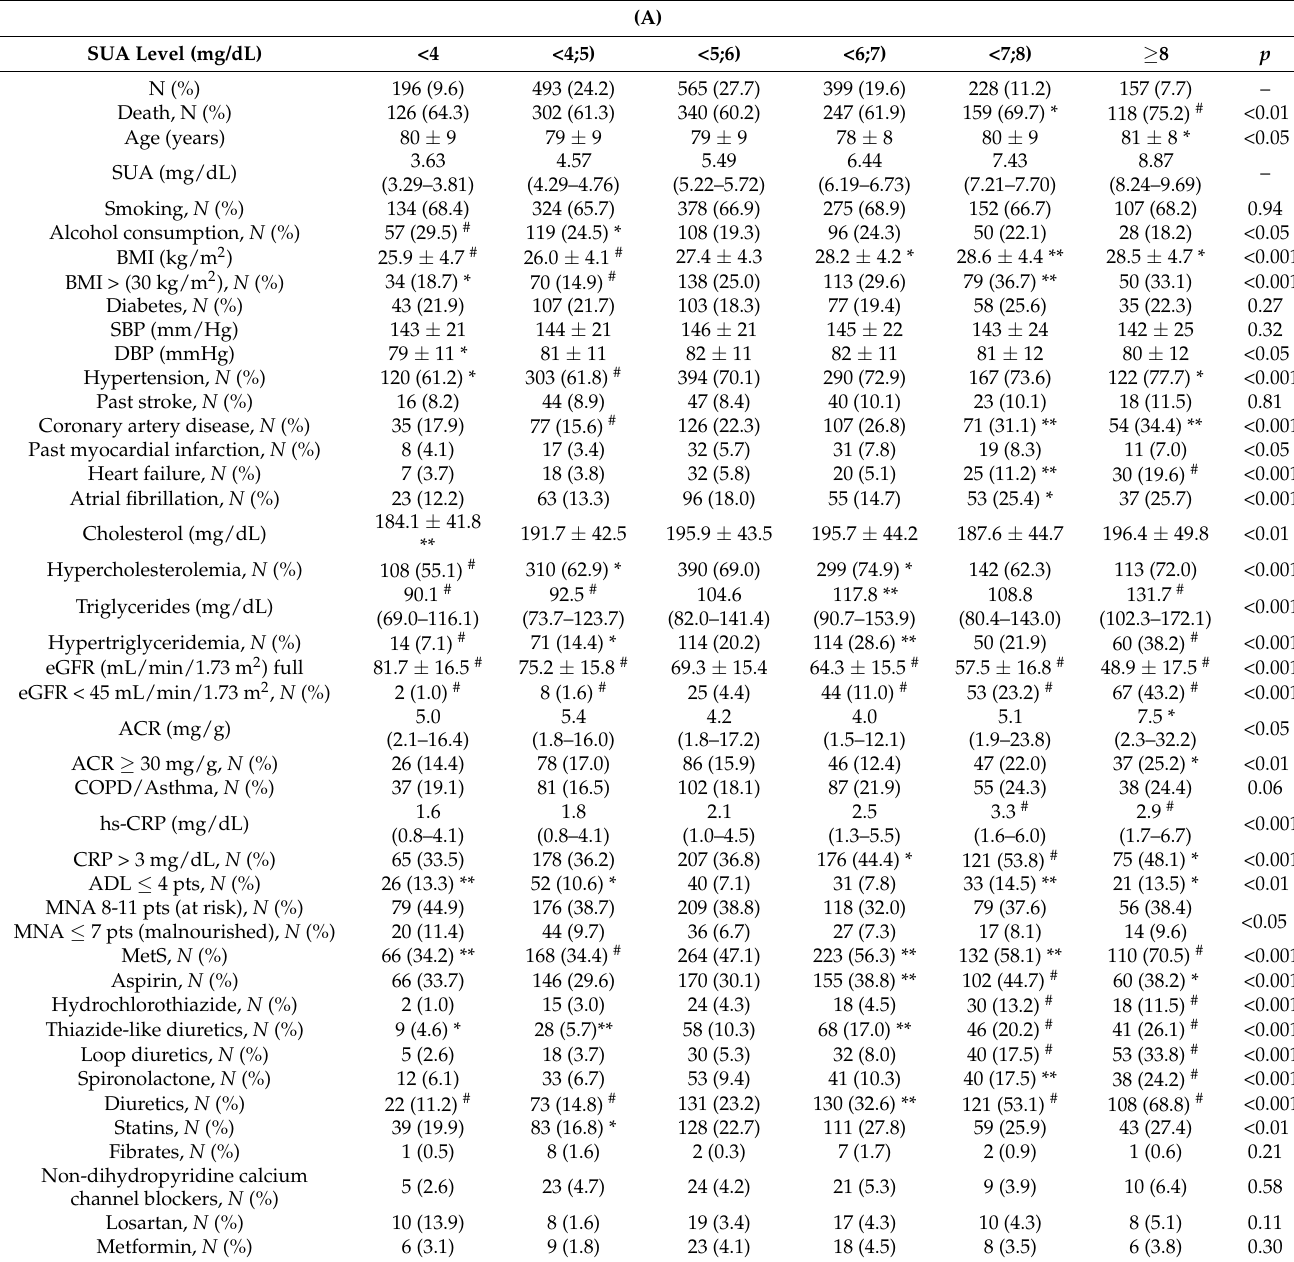
Table 1. ( A ). The characteristics of the male SUA level subgroups ( N = 2038; 51.9%). ( B ) The characteristics of the female SUA level subgroups ( N = 1888;